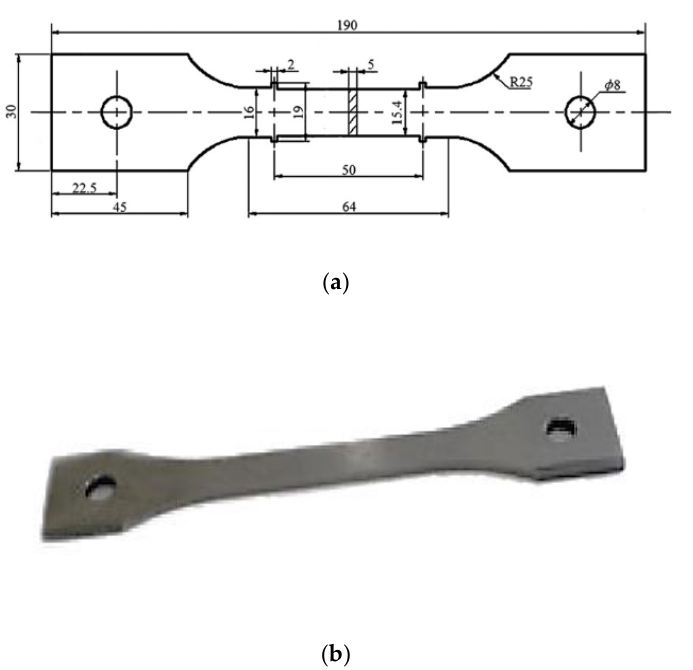
Figure 4. ( a ) Test specimen geometry for the creep test in FEA. ( b ) Sample photo of specimen [51]. The physical properties for the isotropic material SS- 316, Young’s modulus , and Poisson’s ratio were taken from ASME BPVC section II part D, sub-part 2 standards [44]